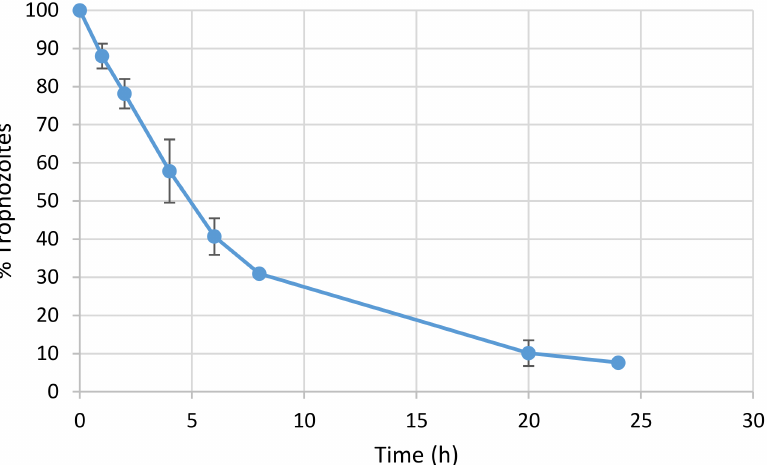
Figure 5. Giardia intestinalis destruction curve in the presence of metronidazole microparticles (2 mg/mL) at pH =